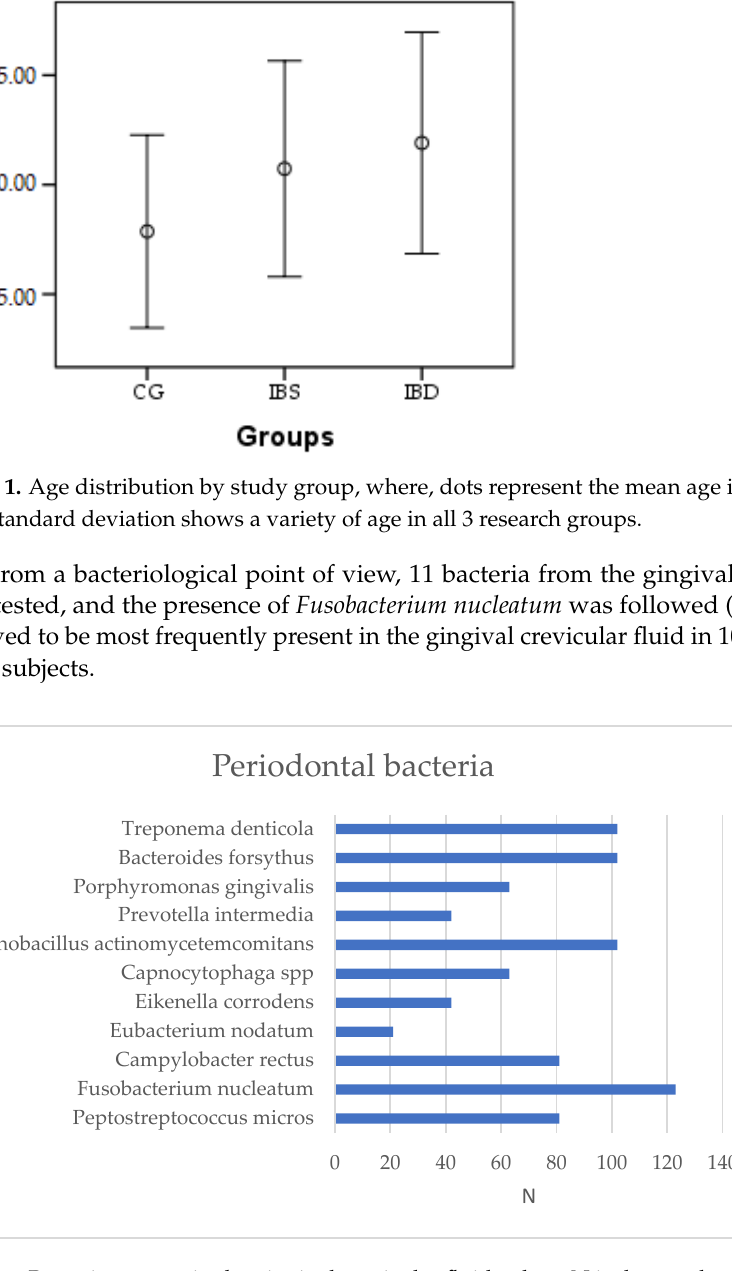
39 patients presented an infection with six bacteria out of the